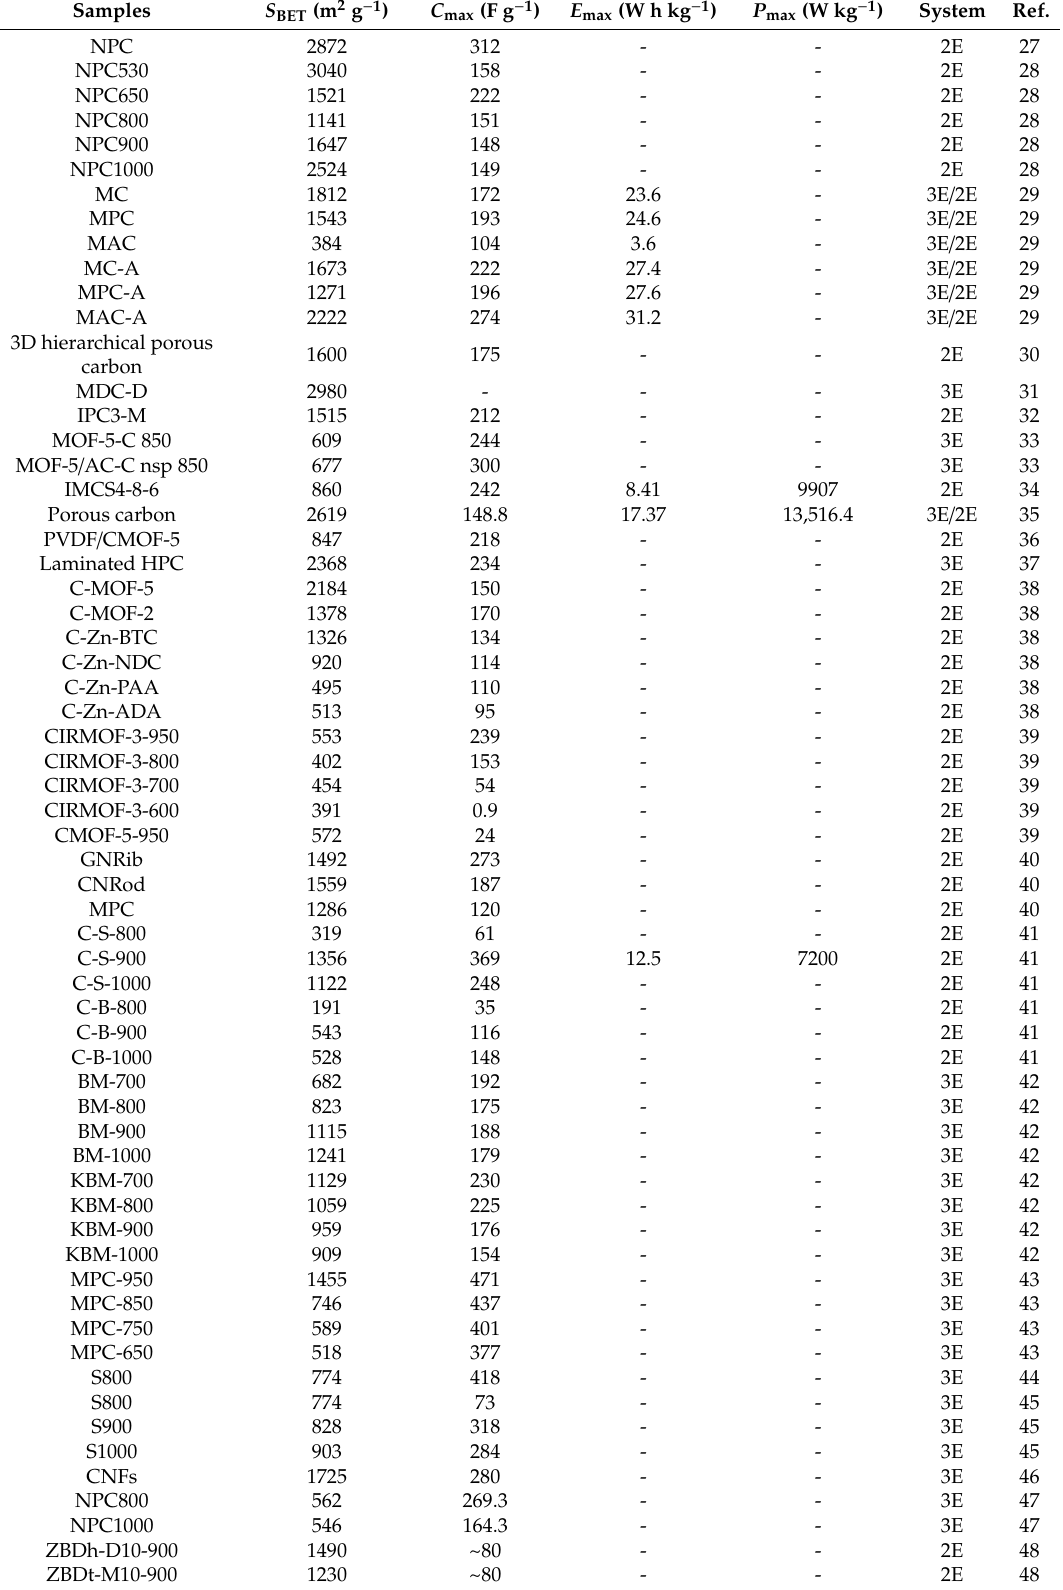
Table 1. The electrochemical capacitive performances of porous carbons derived from MOF-5 and other non-ZIF-based